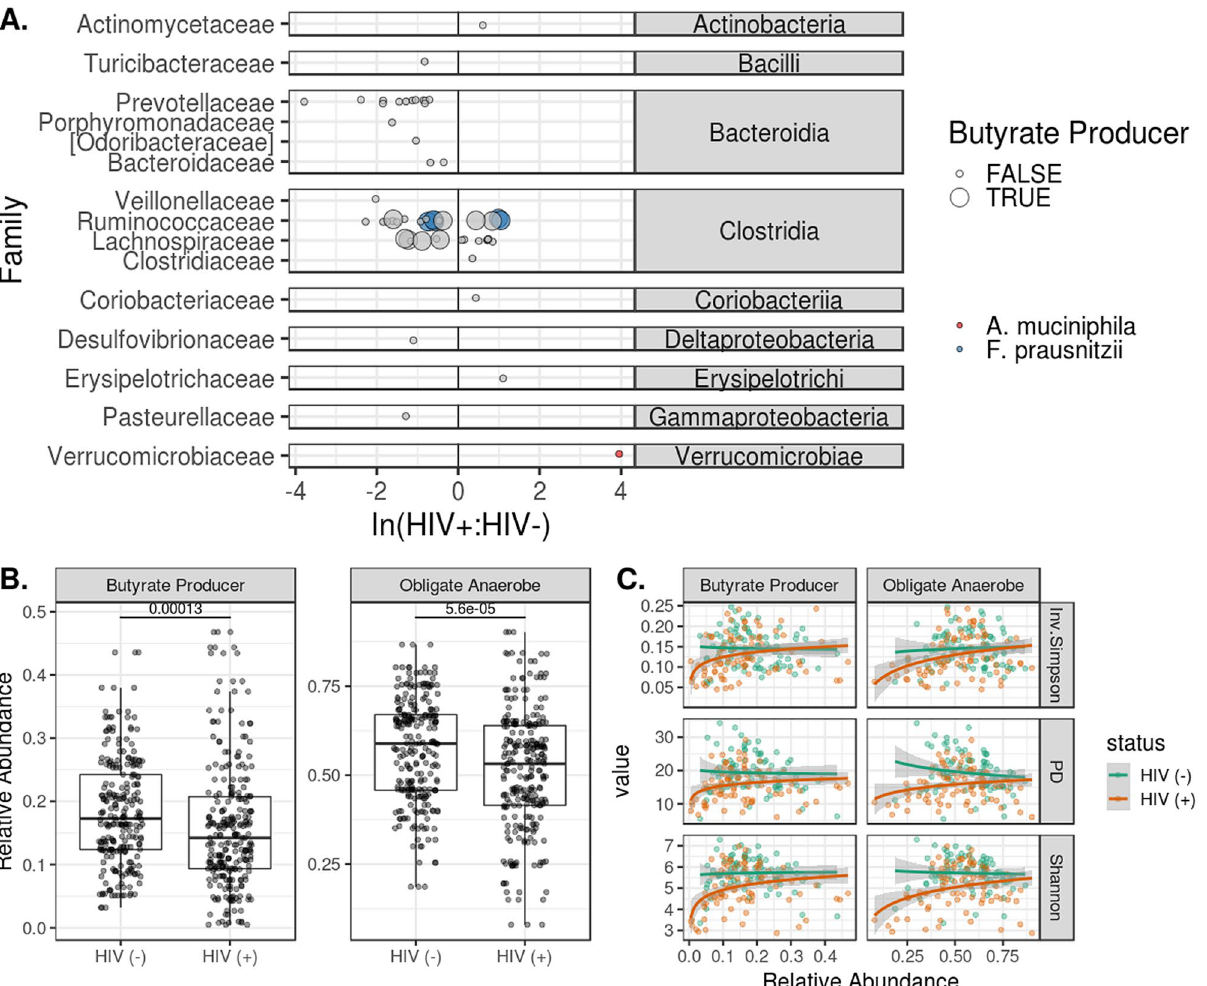
Figure 4. Differential abundance of ASVs and microbiome function by HIV status. Differentially represented ASVs in the HIV infected and HIV non infected cohorts were identified via paired, Wilcoxon tests. Mean relative abundances were calculated for these ASVs for the HIV-negative and positive cohorts. In ( A ), the log- ratio of those mean abundances are plotted on the x axis, with ASVs more abundant in the HIV infected cohort having a ratio greater than 0. ASVs are grouped at the class level, and the family-level taxonomic assignment is given on the y axis. ASVs that were predicted to produce butyrate are shown as large circles, while small circles donate ASVs that are not capable of butyrate production. ASVs mapped to A. muciniphila and F. prausnitzii are colored red and blue, respectively. ASVs with genus-level taxonomic assignments were filtered against the “List of Prokaryotes according to their Aerotolerant or Obligate Anaerobic Metabolism” and were assigned a binary value for predicted butyrate production and obligate anaerobic growth. Relative abundances for ASVs predicted to have these traits are shown in ( B ). There were differing relative abundances of butyrate producers and obligate anaerobes by HIV status (p < 0.001). ( C ) Depicts the log-linear relationships between the relative abundance of these traits and the corresponding alpha diversity (p <